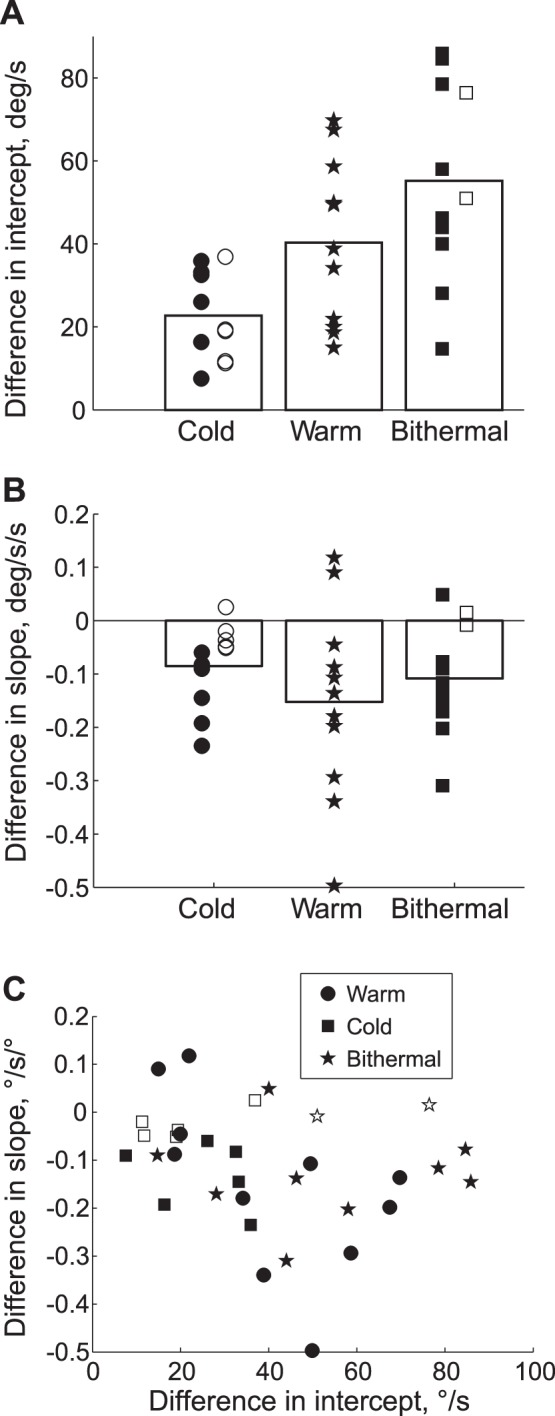
Linear regression of velocity on position at the time of peak nystagmus.A. Each point shows the difference in intercept from the control trial for an individual subject and the bars are means. Open symbols indicate the fitted slopes were not significantly different from control values. B. Each point shows the change in slope from the control trial for each subject and the bars are means. Open symbols indicate the difference in slopes from control values were not significantly different zero. C. The slopes (from panel B) are plotted against the intercepts (from panel A). Open symbols indicate the difference in slopes from control values were not significantly different from zero.